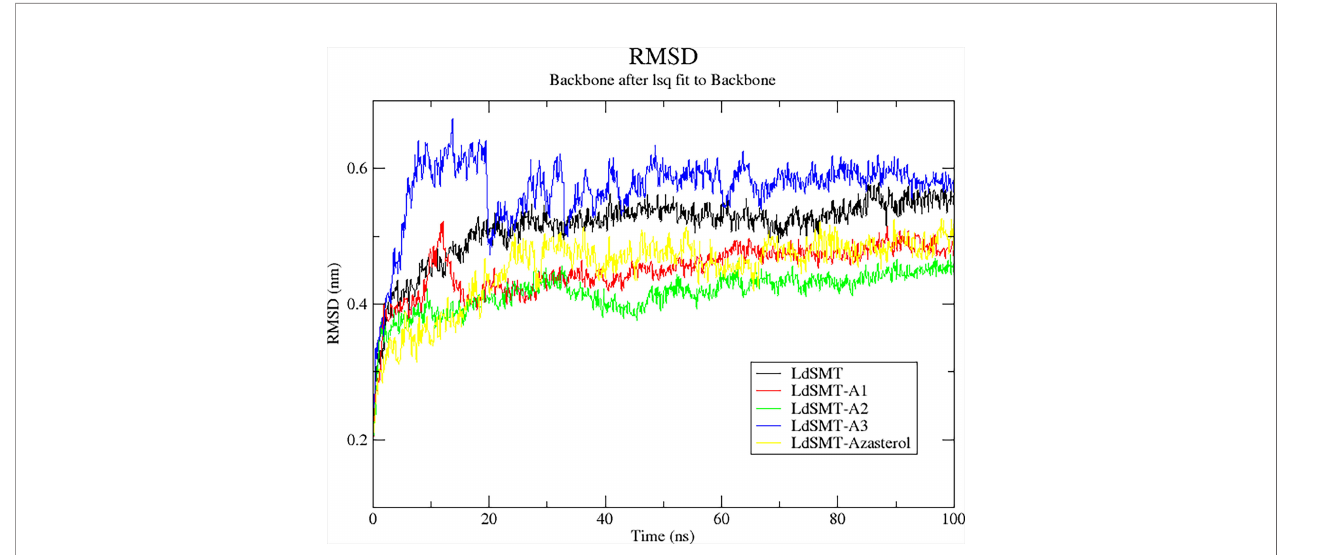
FIGURE 6 | Root mean square deviation (RMSD) plot of 100 ns molecular dynamics (MD) simulations of the Ld SMT – ligand complexes using